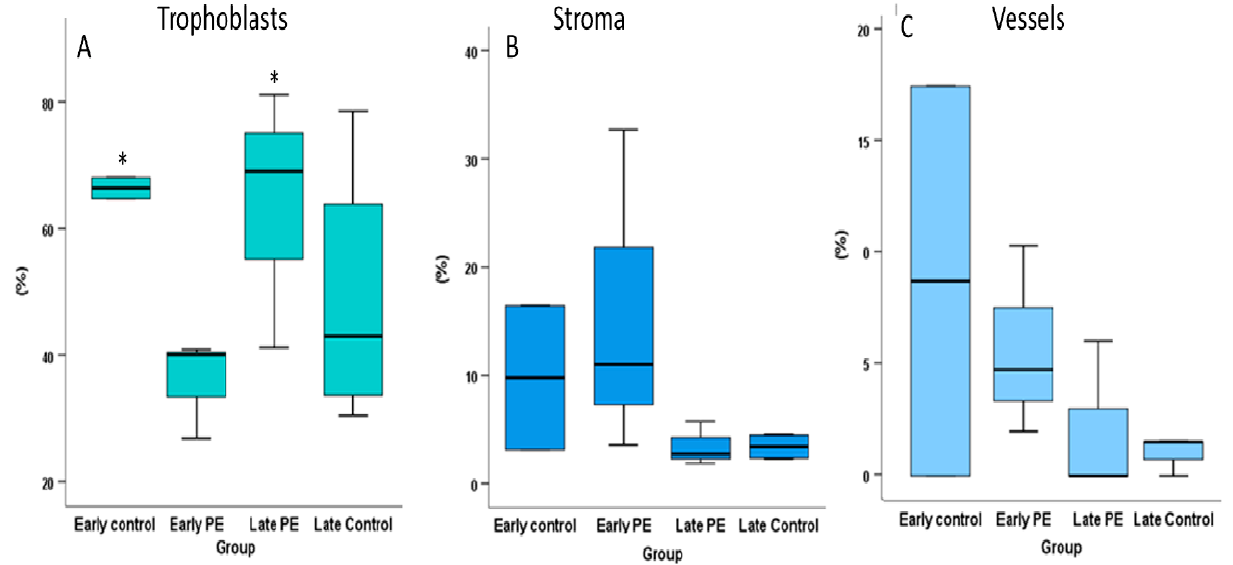
Figure 4. Semi-quantitative analysis of CD24 staining. ( A ) Villous trophoblast, ( B ) stroma, ( C ) vessels. ( A ) Villous trophoblast staining in early preeclampsia cases was lower compared to staining in gestational age-matched preterm delivery cases. In comparison, labeling of term delivery controls was not significantly different to late PE cases. Early PE was significantly lower compared to age-matched PTD cases as well as compared to late PE cases. ( B , C ) No significant differences could be detected for villous stroma and placental blood vessels. * p < 0.05 by Mann Whitney a-parametric test between the two early and the two term groups. Table 4. Quantitative analysis of CD24